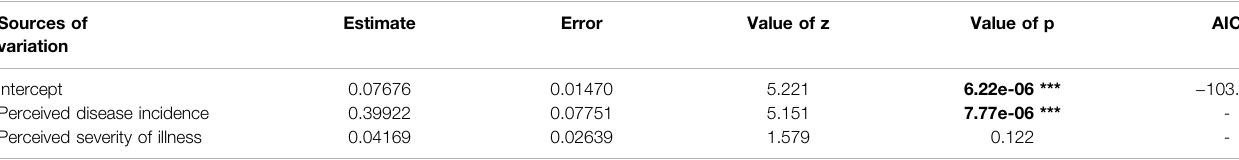
TABLE 6 | Generalized Linear Model used to test the effect of incidence and severity of diseases perceived by farmers in the Catimbau NAPAR on the frequency of used adaptive strategies. The p -valuesfor the signi fi cant predictorsare highlighted in bold. Signi fi cance code p -value: *** [0, 0.001]; ** (0.001, 0.01]; * (0.01, 0.05]; (0.05,0.1]; (0.1,